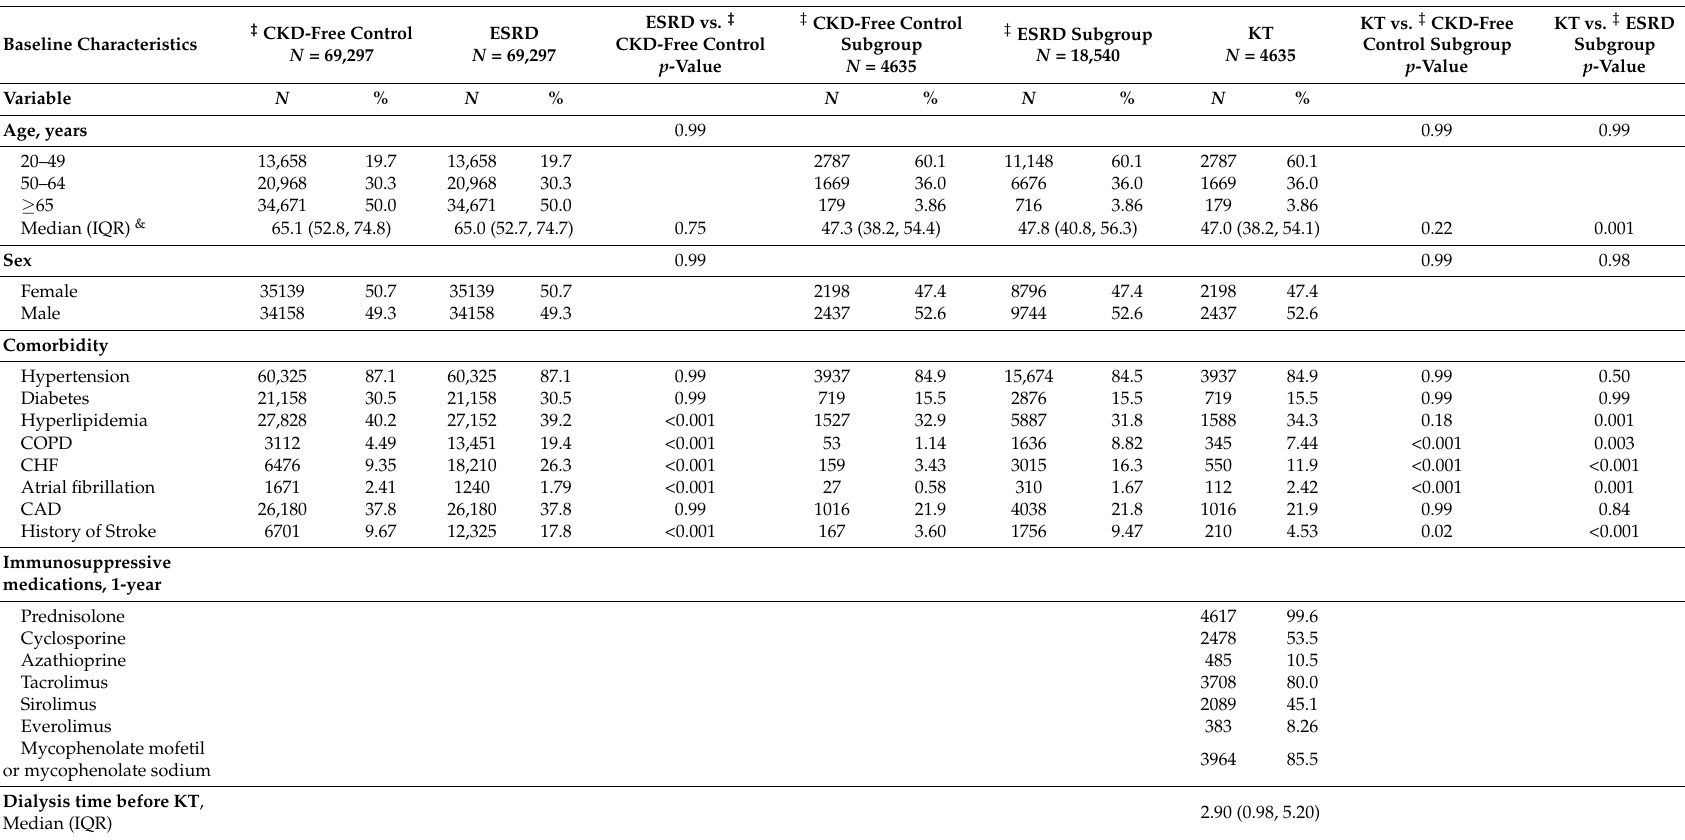
Table 1. Demographic characteristics and comorbidities of study participants according to disease